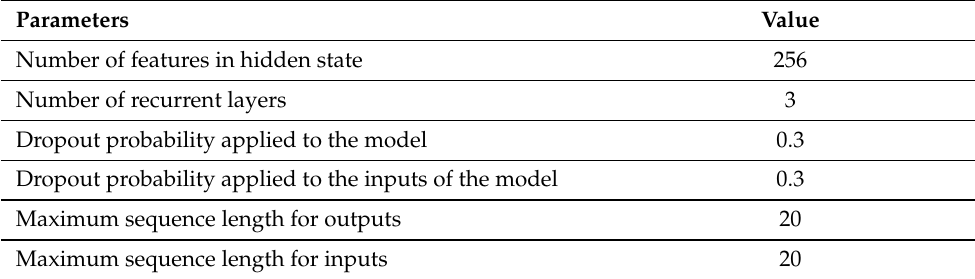
Table A2. Parameters details of the decoder LSTM of the proposed method. The parameters are adjusted according to the experiment, and the best parameter set is